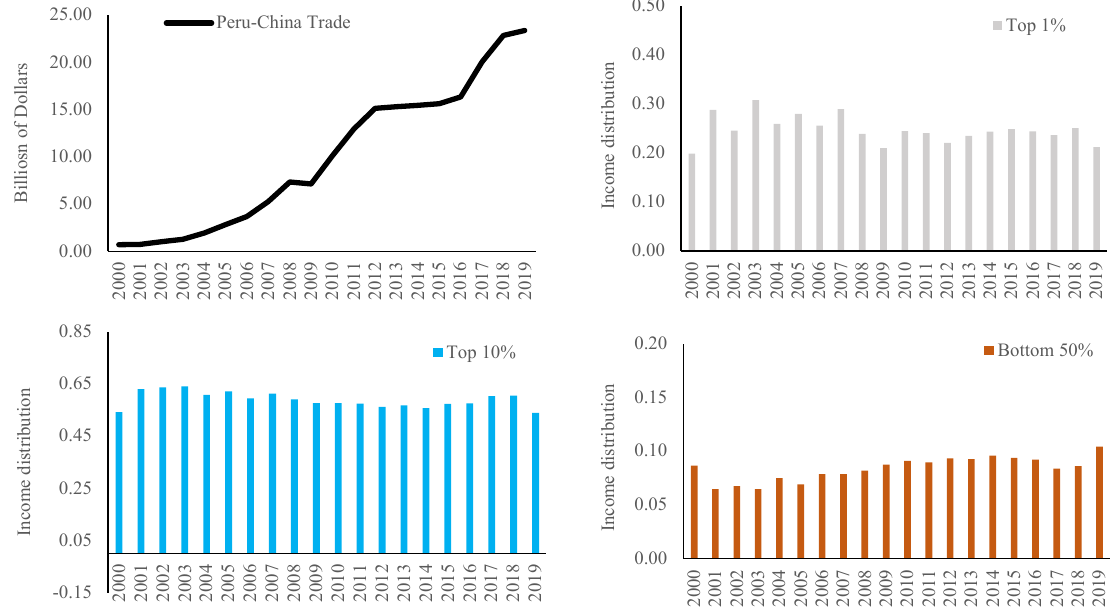
Fig. 2. Income Distribution and Peru – China Trade